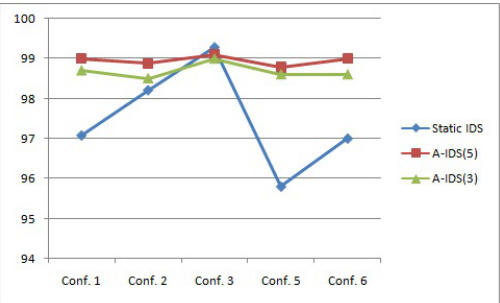
Figure 8. Aggregated accuracy of static and the proposed A-IDS